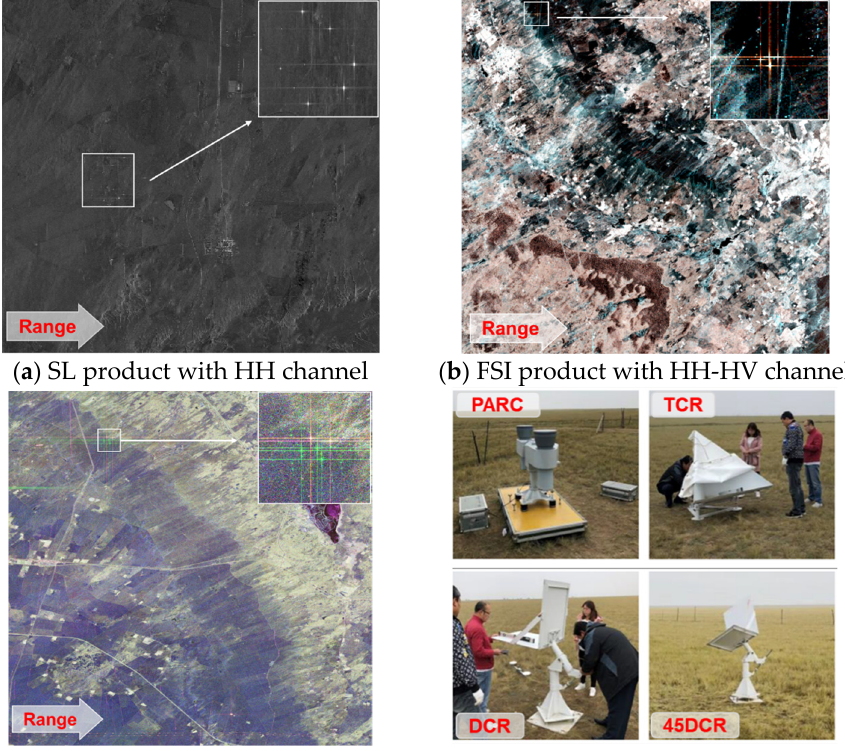
Figure 2. Examples of the GaoFen-3 single-pol, dual-pol, and quad-pol products with CR pixels acquired from the Mongolia calibration site on 17 October 2021, 6 September 2020, and 6 June 2017, respectively. ( a ) The intensity image of the SL mode is represented in decibels (dB); ( b ) a pseudo-RGB image, with the color combination of the HV, HV + VV, and HH channels of the FSI mode; ( c ) a PauliRGB image of the standard QPSI product; and ( d ) the PARC, TCR, DCR and 45°-rotated DCR (45DCR) devices at the Mongolia calibration site in September 2018 [11].